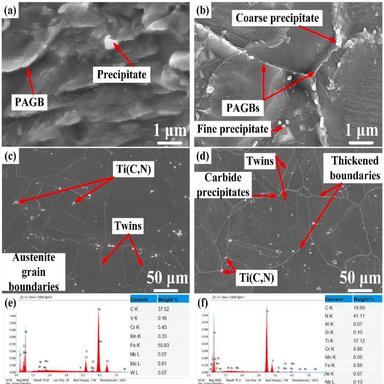
FE-SEM micrographs and EDS spectrum of (a) P91 CGHAZ in AW state; (b) P91 CGHAZ in PWHT state; (c) IN 800HT HAZ in AW state; (d) IN 800HT HAZ in PWHT state; (e) elemental composition of coarse precipitates in PWHT P91 CGHAZ; (f) elemental composition of cuboidal precipitate in PWHT IN 800HT HAZ.